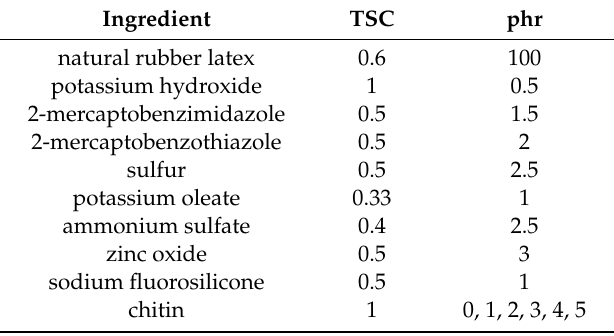
Table 1. Formulation parameters for the synthesis of the chitin–natural rubber latex foam (NRLF) composites. Ingredient TSC phr natural rubber latex